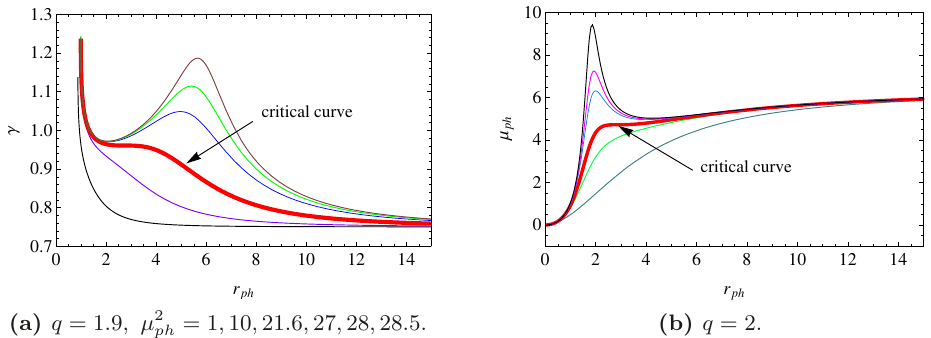
Figure 2. γ and µ ph vs. r ph with P = 0 . 003 , M = 2. The non-linear YM parameter is set to 0 . 85 , 0 . 95 , 0 . 98 , 1 , 1 . 005 , 1 . 01 in the r ph µ ph diagram from the bottom to the top. −